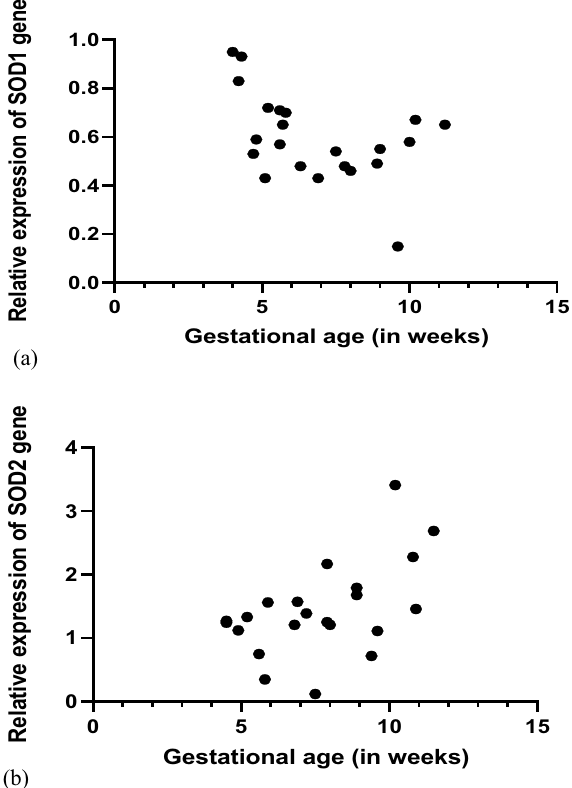
Figure 4. Determination of correlation between relative expressions of ( a ) SOD1 ( b ) SOD2 with gestational age in Chlamydia trachomatis -positive recurrent spontaneous aborters (Spearman’s rank correlation